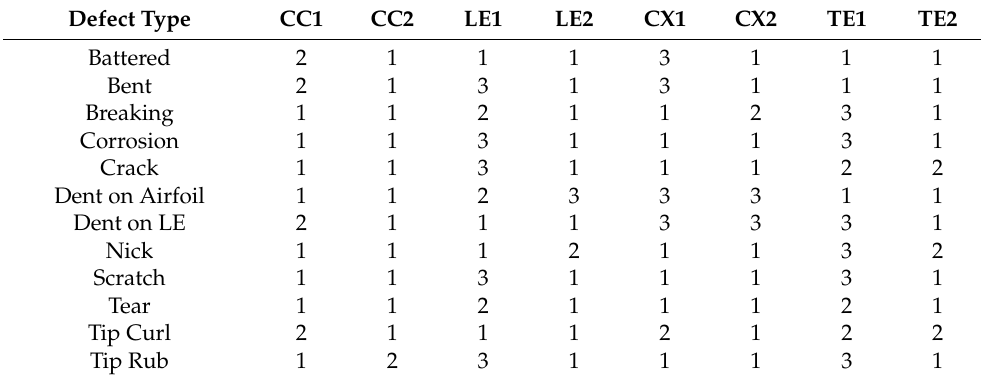
Table 10. Correlation table of expert rating of image acquisition view for each defect